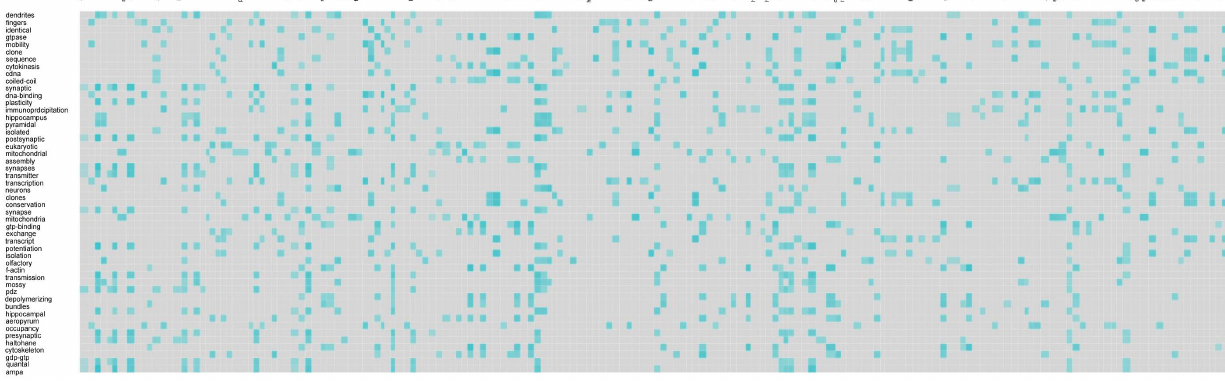
Figure 6. Textrous!- mediated individual processing output of an exemplary large dataset. The heatmap representation (teal-colored blocks indicate strongly-associated gene-word interactions in an intensity-sensitive manner: grey blocks indicate no significant interaction) indicates the gene (vertical)-word (horizontal) interactions within the large mouse learning dataset created with Textrous! individual processing.